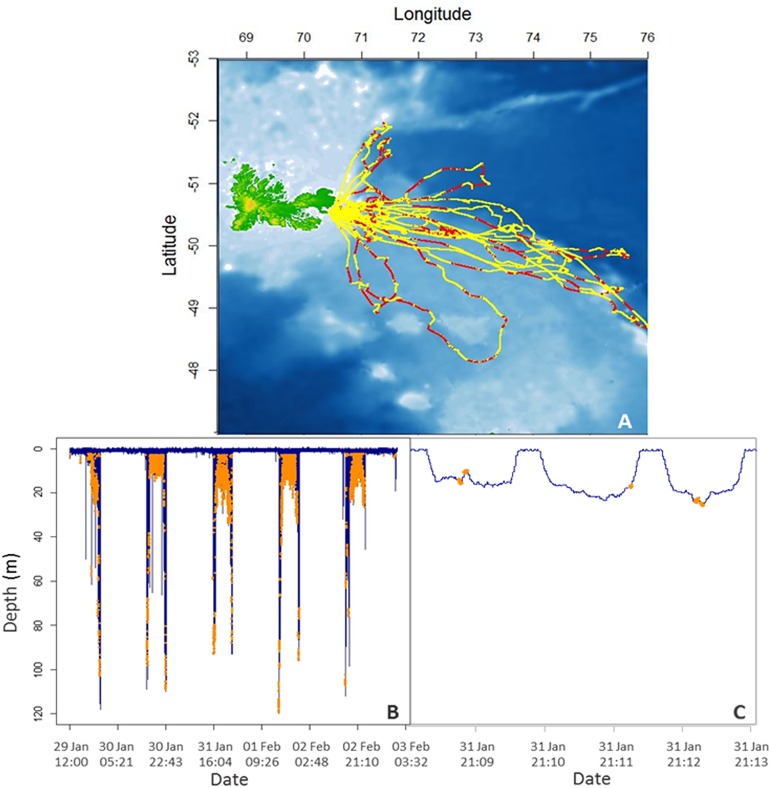
Foraging locations of the 20 Antarctic fur seal females tracked on the Kerguelen plateau (A), and example of a dive profile during a foraging trip (B) or over a 5-min period (C). Red dots show where the animals attempted to capture prey within the range of their foraging location (A, along the yellow GPS tracks) and orange dots where prey capture attempts occurred during the dives (B, C).